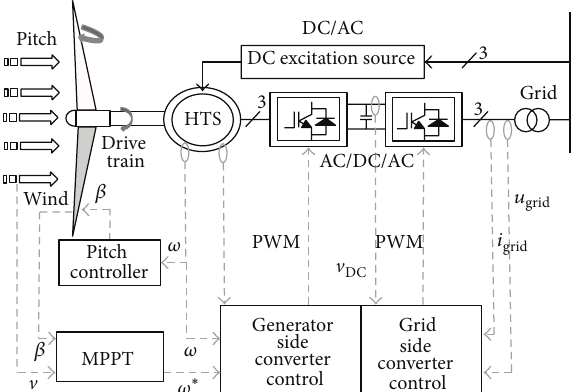
Figure 6: Configuration of a HTSG wind